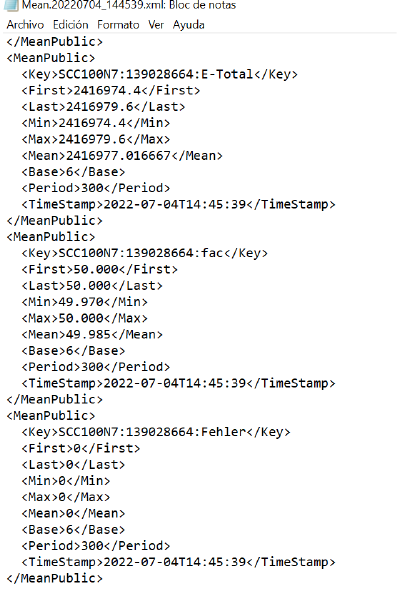
Figure 2. Fragment of the information contained in an XML file with the information record of a group of inverters of a PV plant.